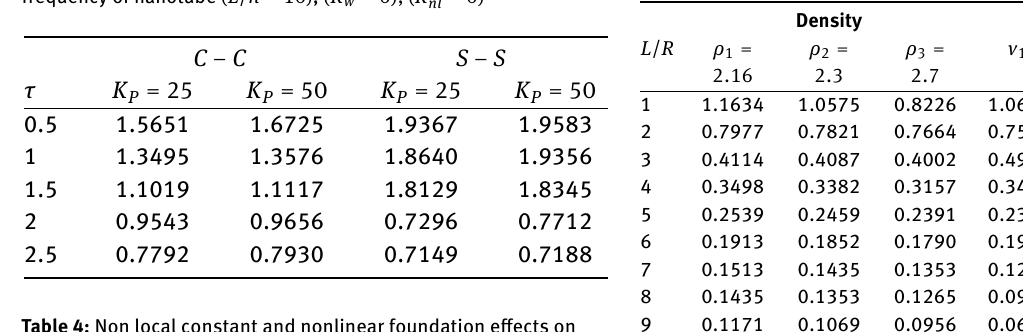
Table 4: Non local constant and nonlinear foundation effects on